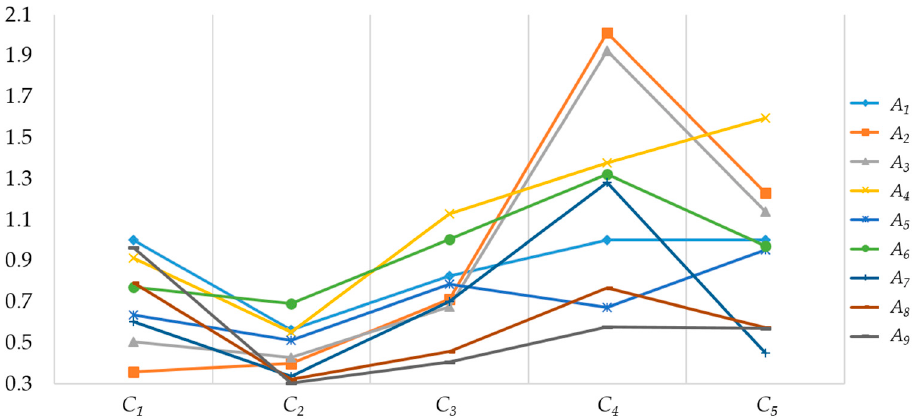
Figure 2. The point relational degree between each alternative and the index data.